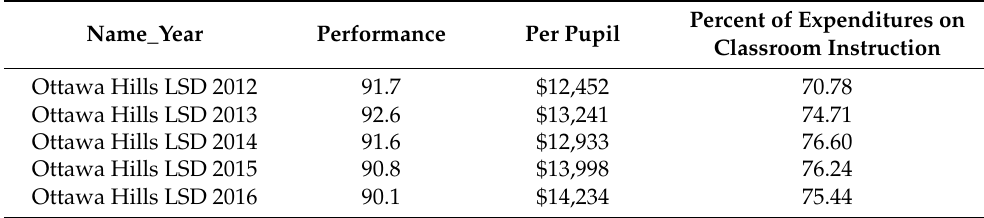
Table 1. School district data in different years.